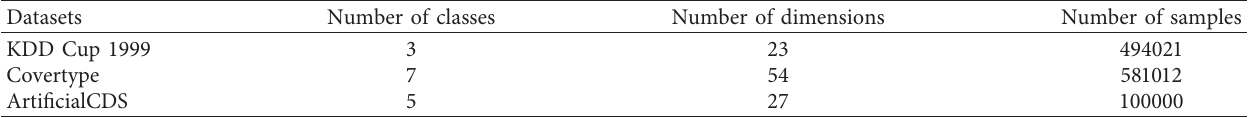
Table 2: Parameter of different datasets.